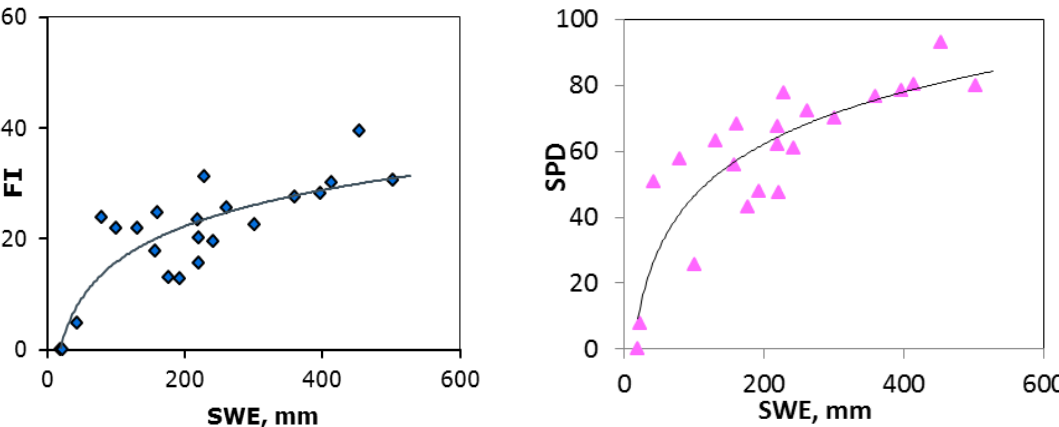
Figure 8. FI and SPD as a function of SWE (mm). The regression lines are: FI = 9.4 Ln(SWE) − 27.6 (R 2 = 0.71); SPD = 22.76 Ln(SWE) − 58.3 (R 2 = 0.76).